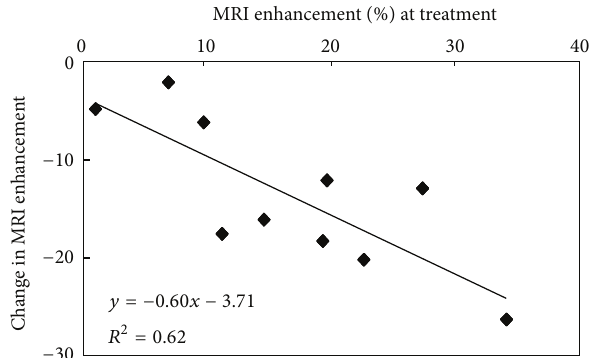
Figure 5: The amount of MRI signal enhancement in the abdominal aorta of atherosclerotic rabbits following treatment with 𝛼 ] 𝛽 3 - integrin targeted fumagillin nanoparticles correlates with the ther- apeutic effect measured 1 week later. This finding suggests that combined imaging and therapeutic nanoparticles can be used to predict the treatment effects at the time of treatment. Reprinted with permission from